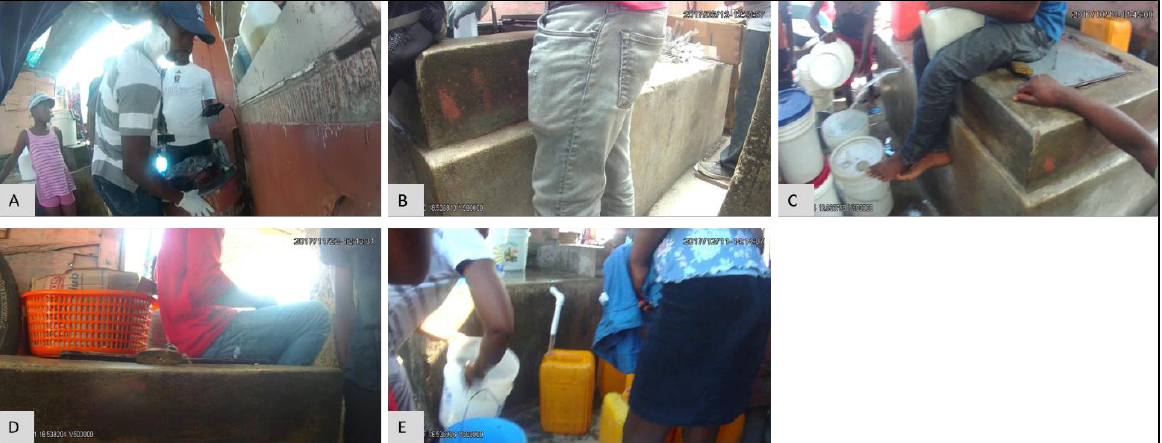
Figure 17. SV images for water point P1 for: ( A ) May, ( B ) June, ( C ) October, ( D ) November, and ( E ) December 2017.